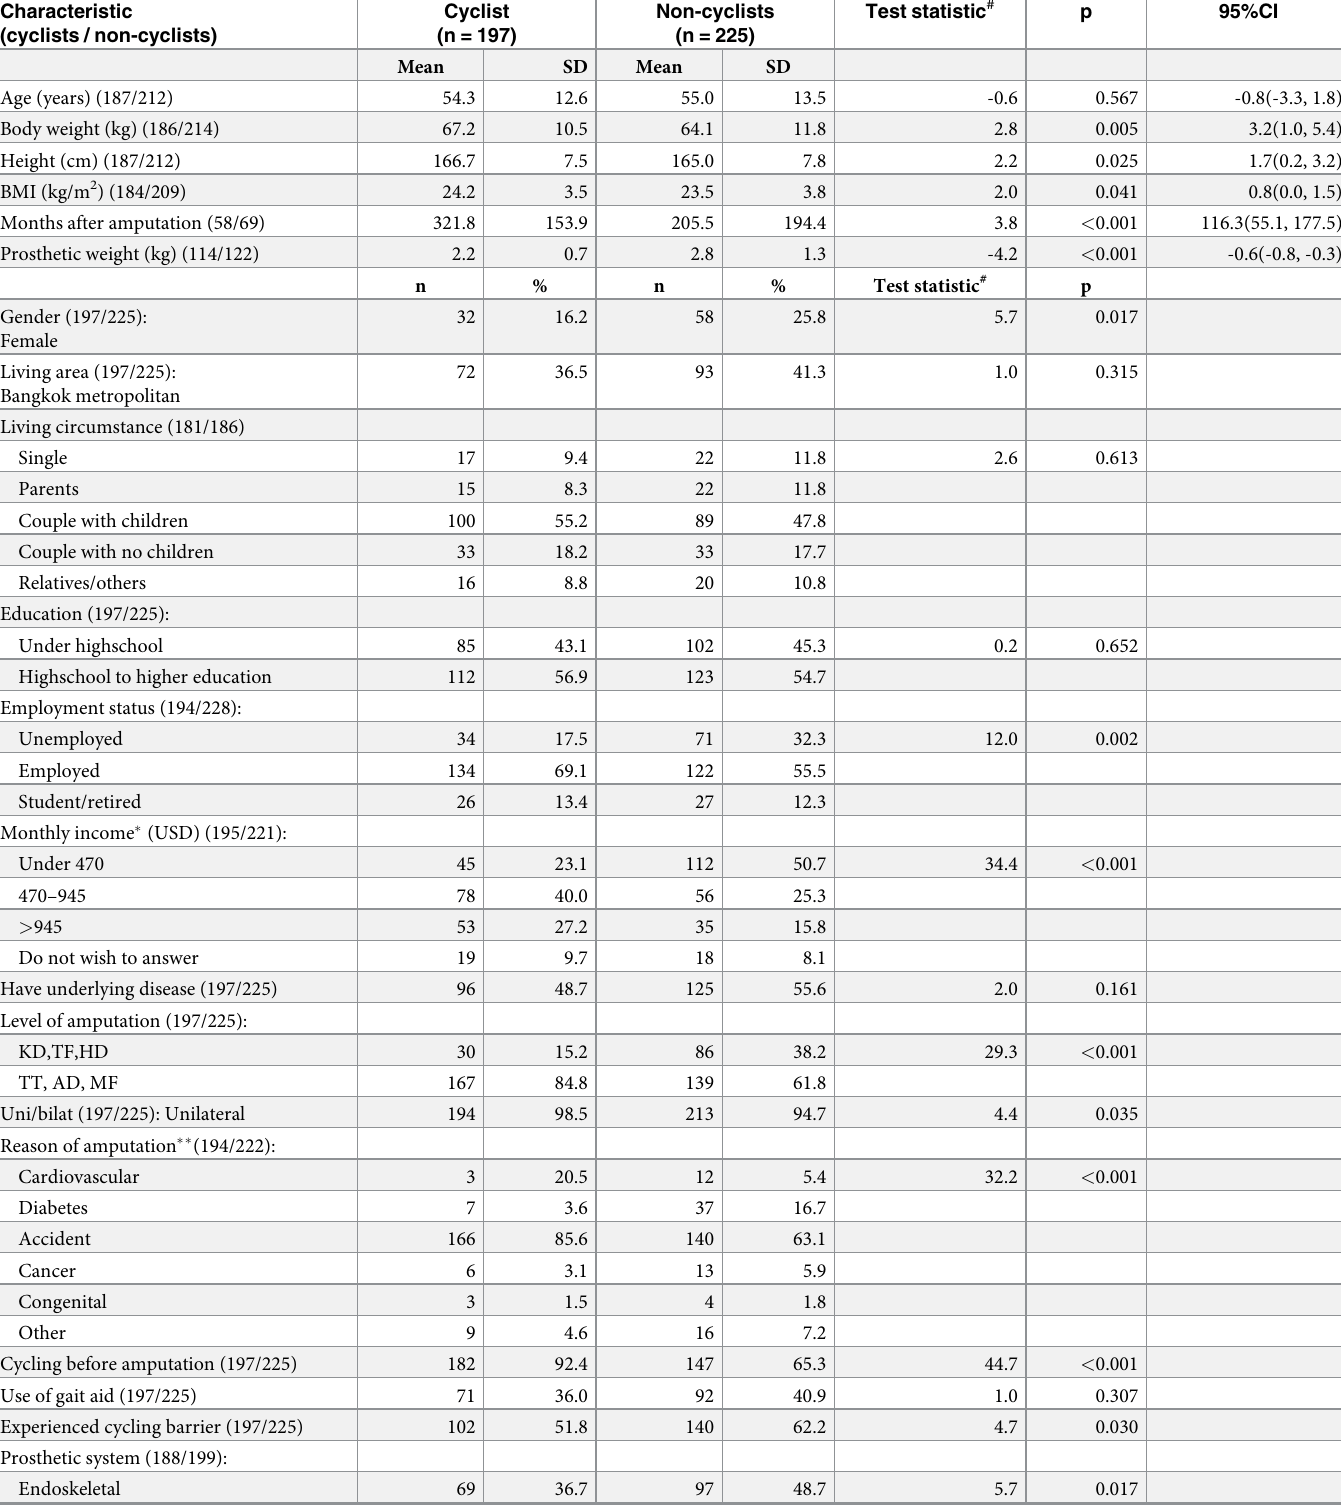
Table 2. Characteristics of cyclists and non-cyclists. Characteristic (cyclists /